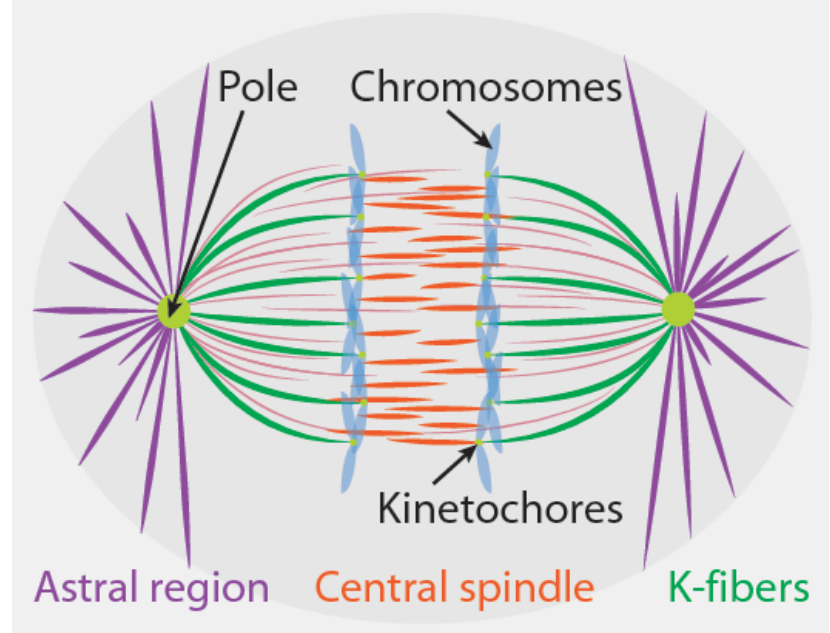
Figure 1. Three force-generating sites that are found in diverse spindles are kinetochores, the astral region, and the central spindle.